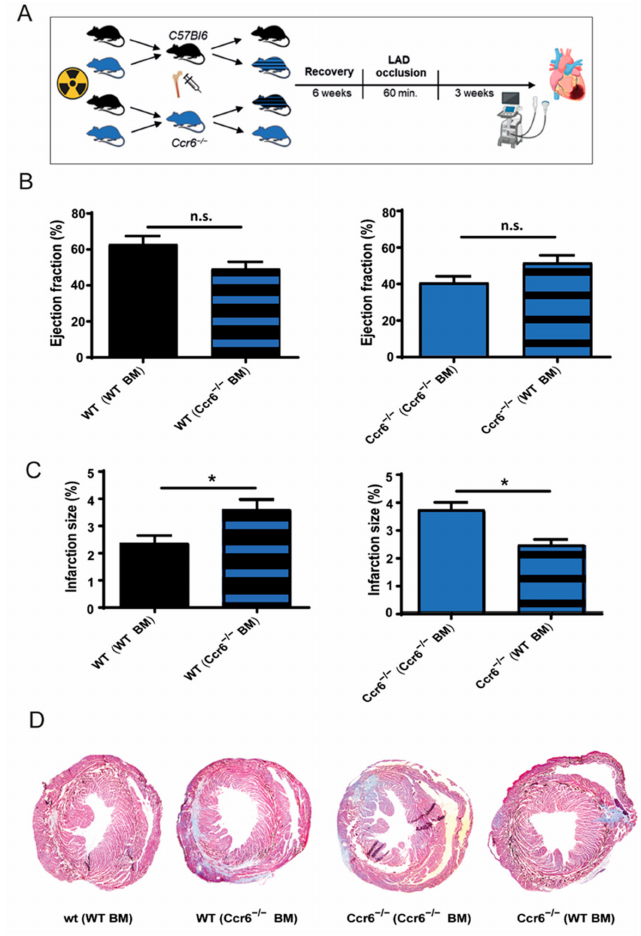
Figure 2. CCR6 deficiency in the bone marrow results in increased infarction size after ischemia- reperfusion injury. ( A ) Study design of bone marrow transplantation experiments, where the mice were subjected to ischemia-reperfusion injury. Echocardiography was performed 3 weeks after injury. Image was created using Biorender.com (Accessed on 2 September 2021). ( B ) Ejection fraction in wild-type recipient mice receiving either wild-type or Ccr6 − / − BM ( n = 4–6) and Ccr6 − / − recipient mice receiving either wild-type or Ccr6 − / − BM ( n = 3). ( C ) Infarction size in wild-type recipient mice receiving either wild-type or Ccr6 − / − BM ( n = 4–6) and Ccr6 − / − recipient mice receiving either wild-type or Ccr6 − / − BM ( n = 3). ( D ) Representative images of heart sections stained with Gomori’1 step trichrome staining of wild-type recipient mice receiving either wild-type or Ccr6 − / − BM and Ccr6 − / − recipient mice receiving either wild-type or Ccr6 − / − BM. * p <